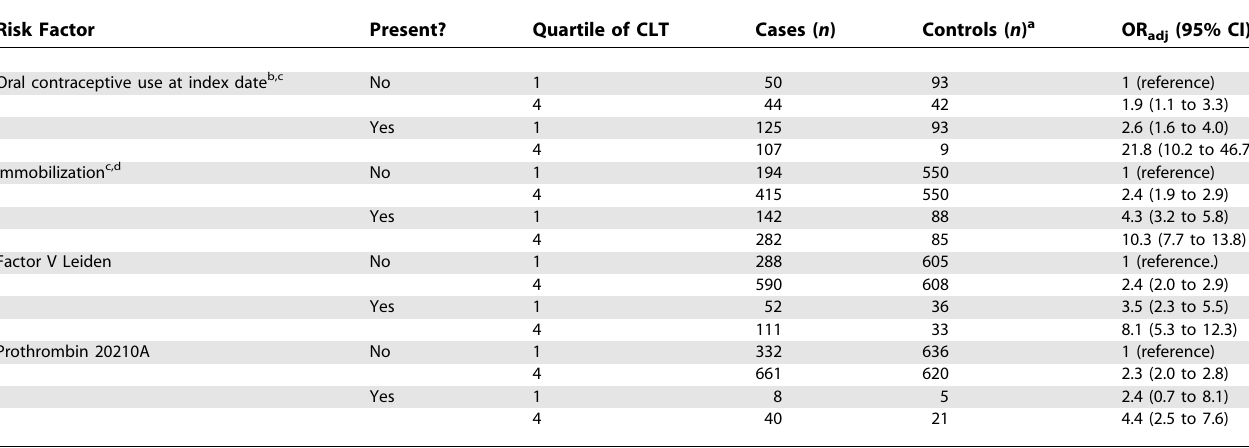
Table 4. Hypofibrinolysis, Presence of Established Genetic and Acquired Risk Factors, and Relative Risk of Venous Thrombosis Risk Factor